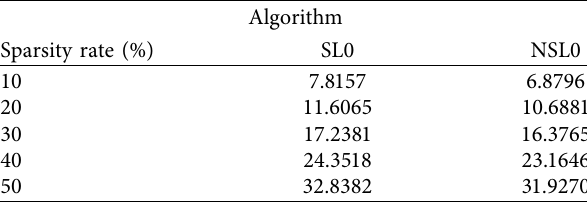
Table 5: Calculation time comparisons between SL0 and NSL0 ( s ).